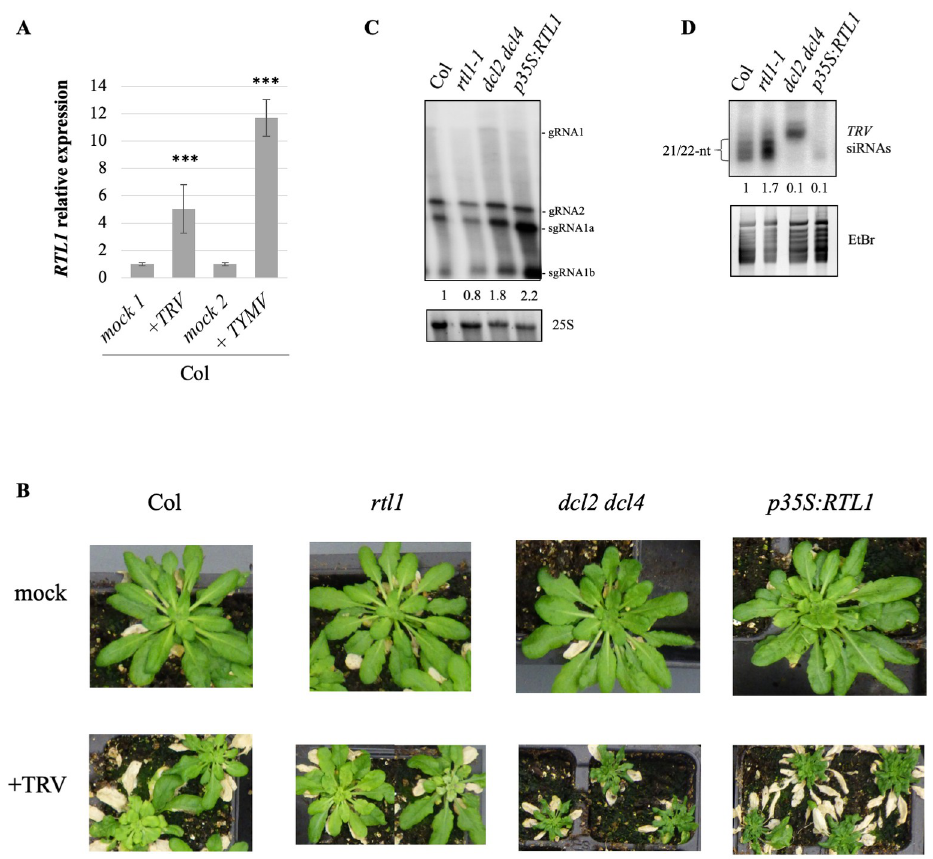
Fig 7. RTL1 favors TRV infection by counteracting anti-viral PTGS. A) RTL1 induction by TRV compared to TYMV. RTL1 expression was analyzed by qRT-PCR on WT plants three weeks after infection. GAPDH expression is used as internal control and data are normalized to non-infected (mock) plants. B) Pictures of Arabidopsis thaliana wild type, rtl1-1 and dcl2 dcl4 mutants and p35S : RTL1 plants three weeks after infection with TRV. Plants were grown under short day conditions. C) TRV genomic RNAs (gRNA) accumulation in Arabidopsis thaliana wild type, rtl1-1 and dcl2 dcl4 mutants and p35S : RTL1 plants four weeks after infection with TRV. Total RNA was extracted from a pool of 16 infected plants per genotype and hybridized with a TRV probe. Data are normalized to Col. D) TRV siRNA accumulation in Arabidopsis thaliana wild type, rtl1-1 and dcl2 dcl4 mutants and p35S : RTL1 plants four weeks after infection with TYMV. Total RNA was extracted from a pool of 16 infected plants per genotype and hybridized with a TRV probe. Data are normalized to Col. For siRNA quantification, only 21 and 22-nt bands were